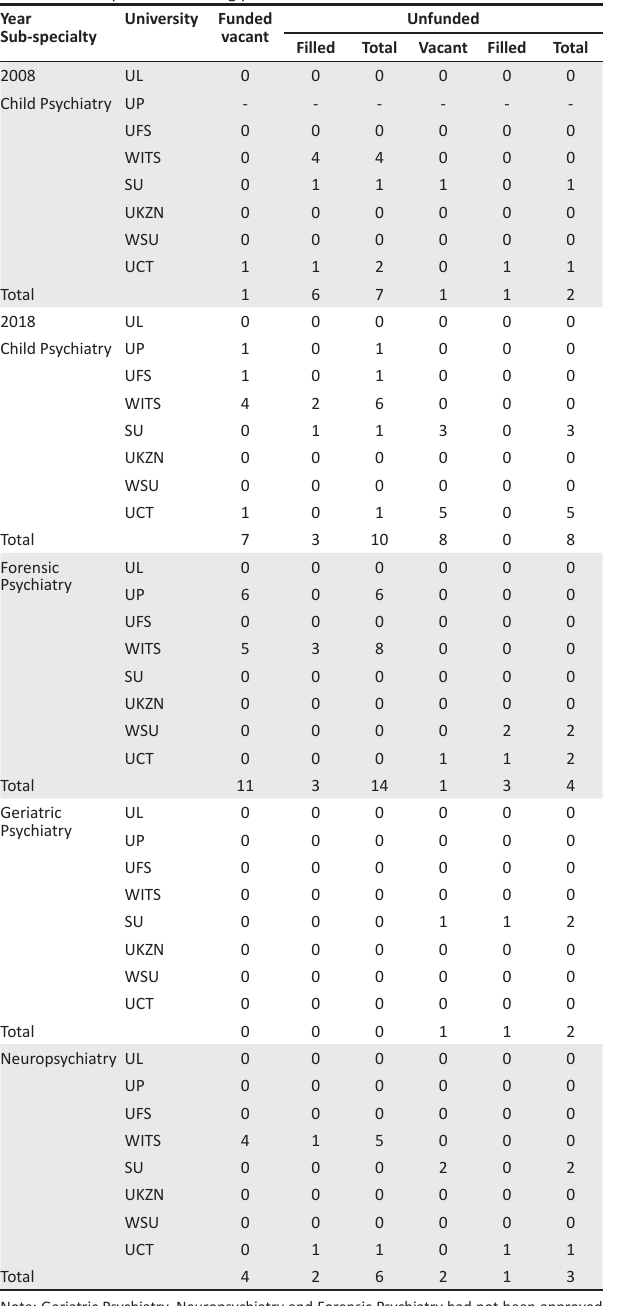
TABLE 3: Number and ratio of consultants and registrars at